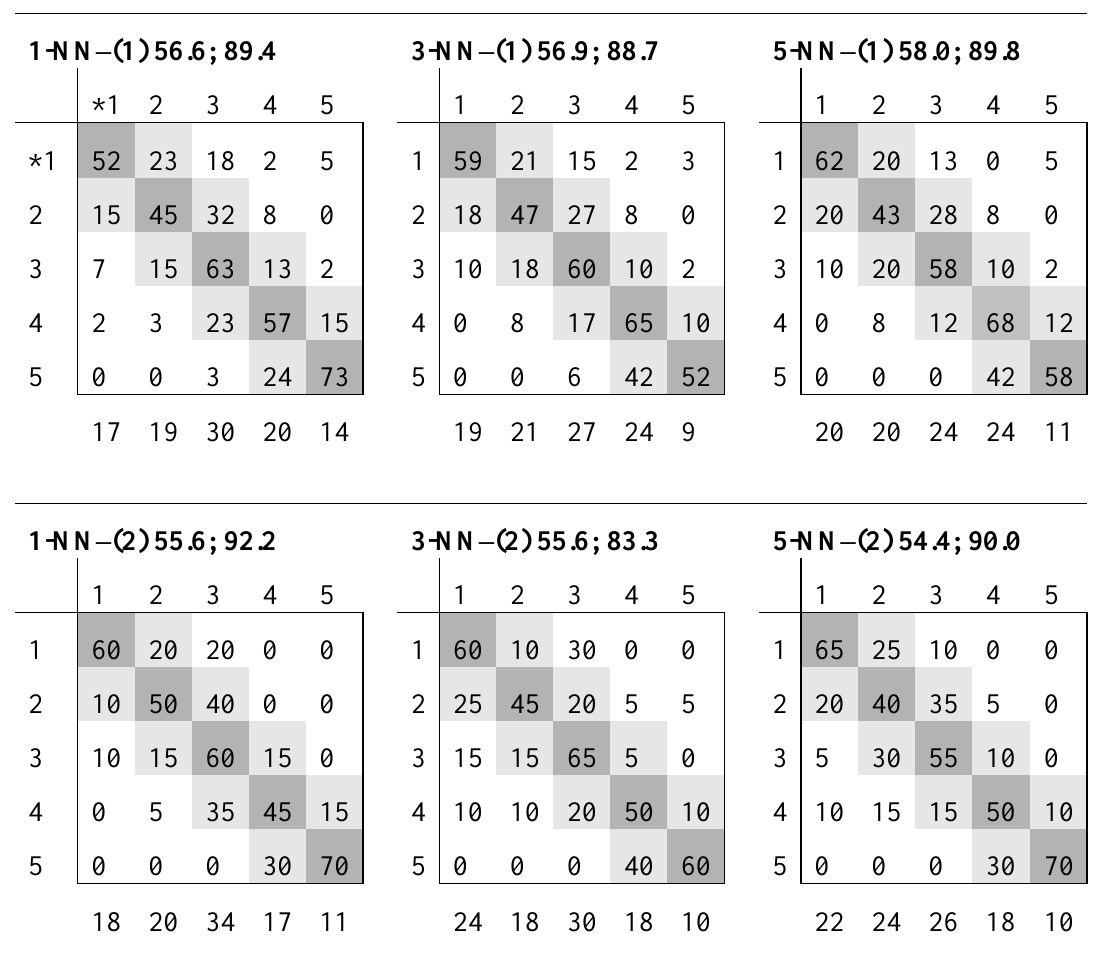
Table 4. Classification success rates (%) matrix obtained by the k-NN method with 1, 3 and 5 nearest neighbors for all forest site types in two approaches: (1) Whole data (n = 274); (2) test data (n = 90). *1 denotes very rich forests (e.g., OMaT), 2 rich (OMT), 3 medium (MT), 4 rather poor (VT) and 5 poor (e.g., CT), including all poor forest sites [1]. 1-NN–(1) 56.6;